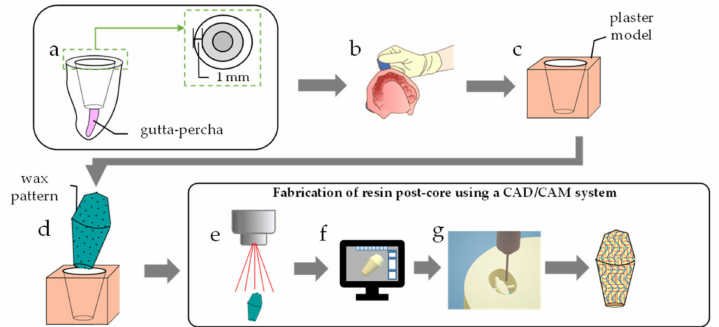
Figure 2. Fabrication of ( a ) CAD/CAM post-core a: Preparing a post hole; ( b ) Taking